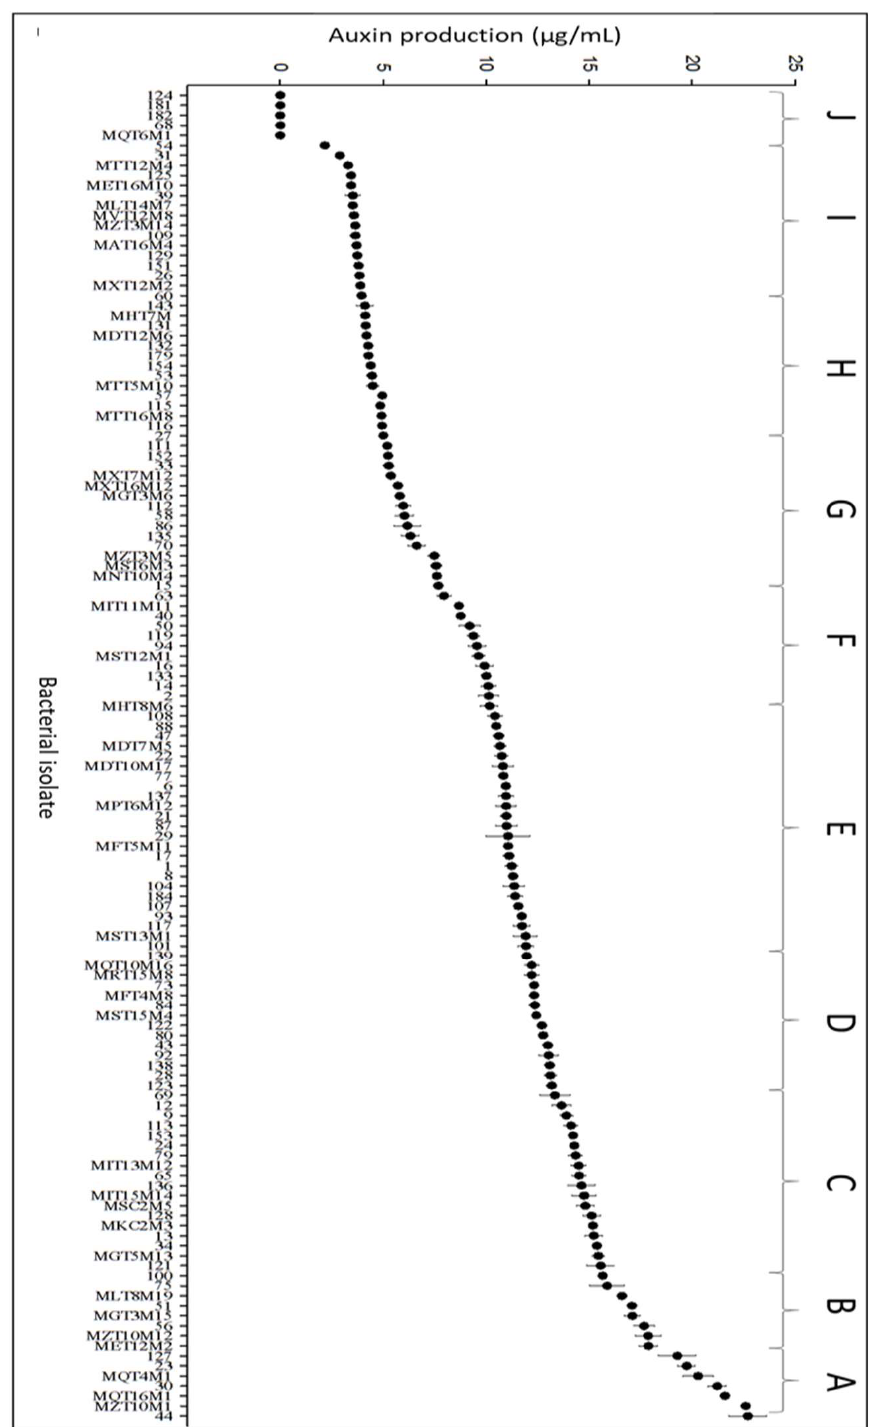
Figure 1. Biosynthesis of auxins by strawberry endophytic bacteria. Different letters differ signifi- cantly from each other by the Scott–Knot test at 5%